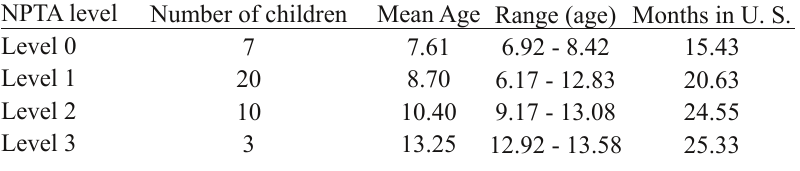
Breakdown of NPTA by means of age and months in U.